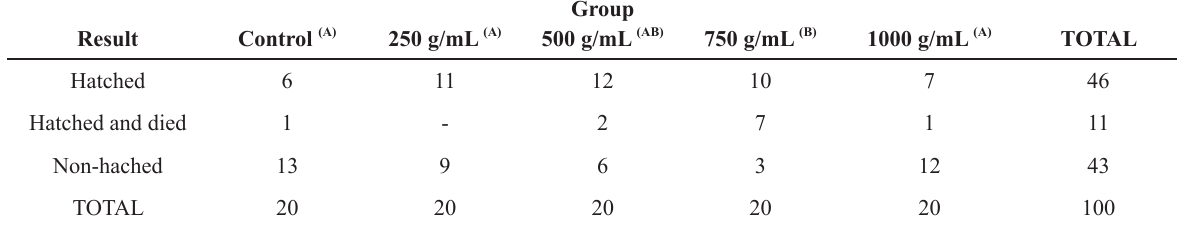
Assessment of embryotoxic and embryostatic effects of aqueous extract of R. mangle in eggs of A. aegypti over 14 days